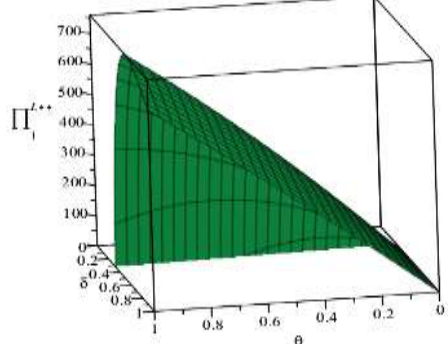
Figure 9. E ff ect of manufacturer’s behavior θ , δ on logistics network under speculative Figure 9. Effect of manufacturer's behavior 𝜃 , 𝛿 on logistics network under speculative conditions.